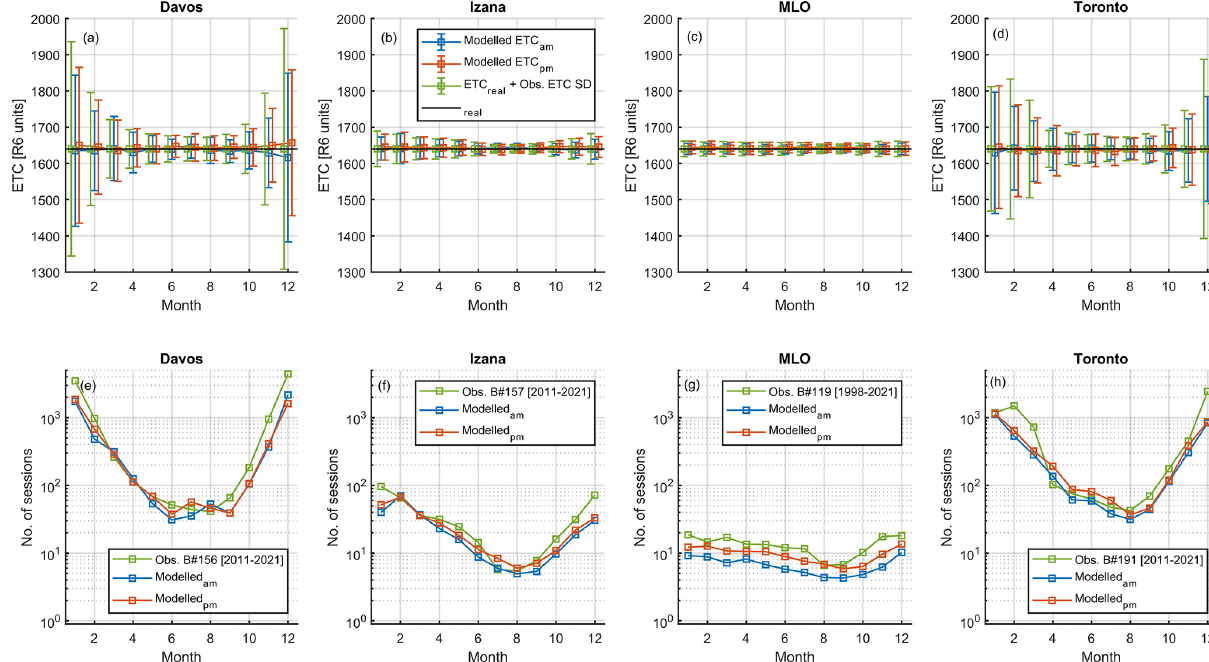
Figure 5. Monthly mean ETC values (a–d) and the number of sessions needed to achieve desired precision of the final ETC product (e–h) for four sites. In the top row, the imaginary Brewer’s true ETC (ETC true ) is shown as black lines; blue and red lines show the modelled monthly mean ETC with its standard deviations (SD); green lines show the ETC real with observation-derived ETC